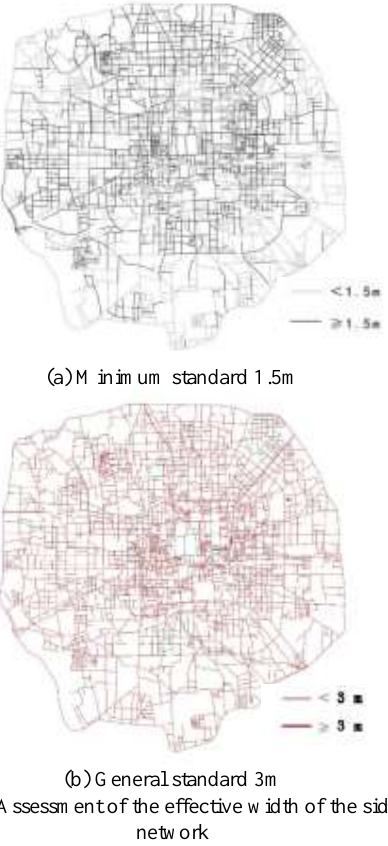
Figure 6. Assessment of the effective width of the sidewalk network